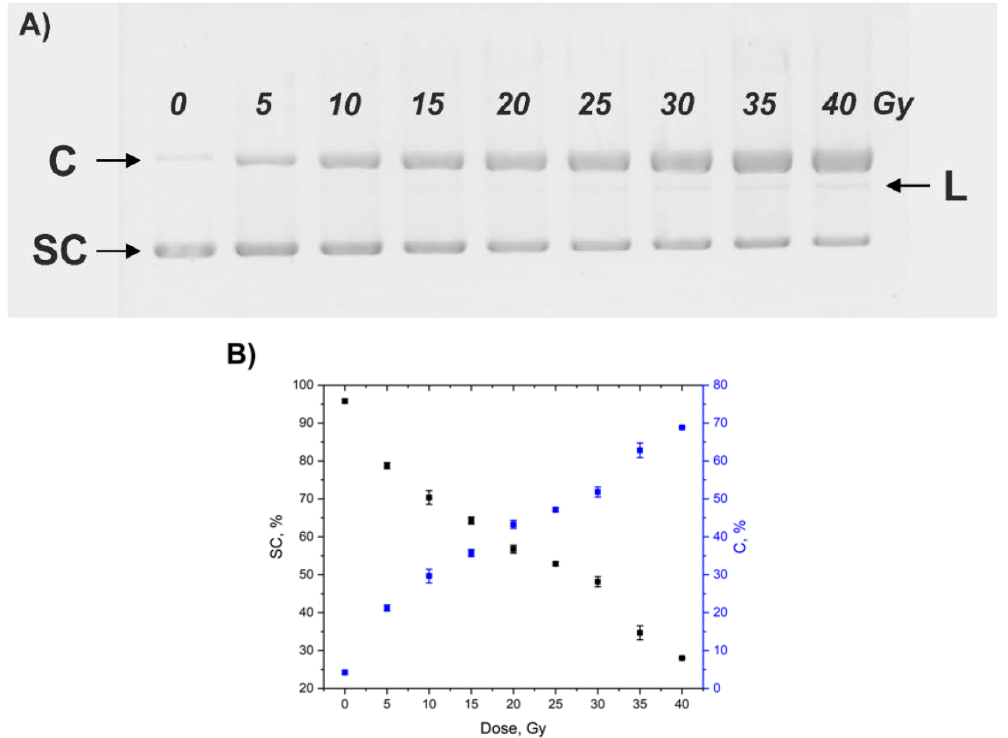
Figure 4. ( A ) Electrophoregram of pBR322 DNA irradiated with 0–40 Gy. SC, supercoiled. C, circular. L, linear forms. ( B ) Dependences of the amounts of SC and C forms of pBR322 DNA on the dose of X-ray irradiation. Error bars are mean confidence intervals calculated by three parallel independent measurements for α = 0.05.